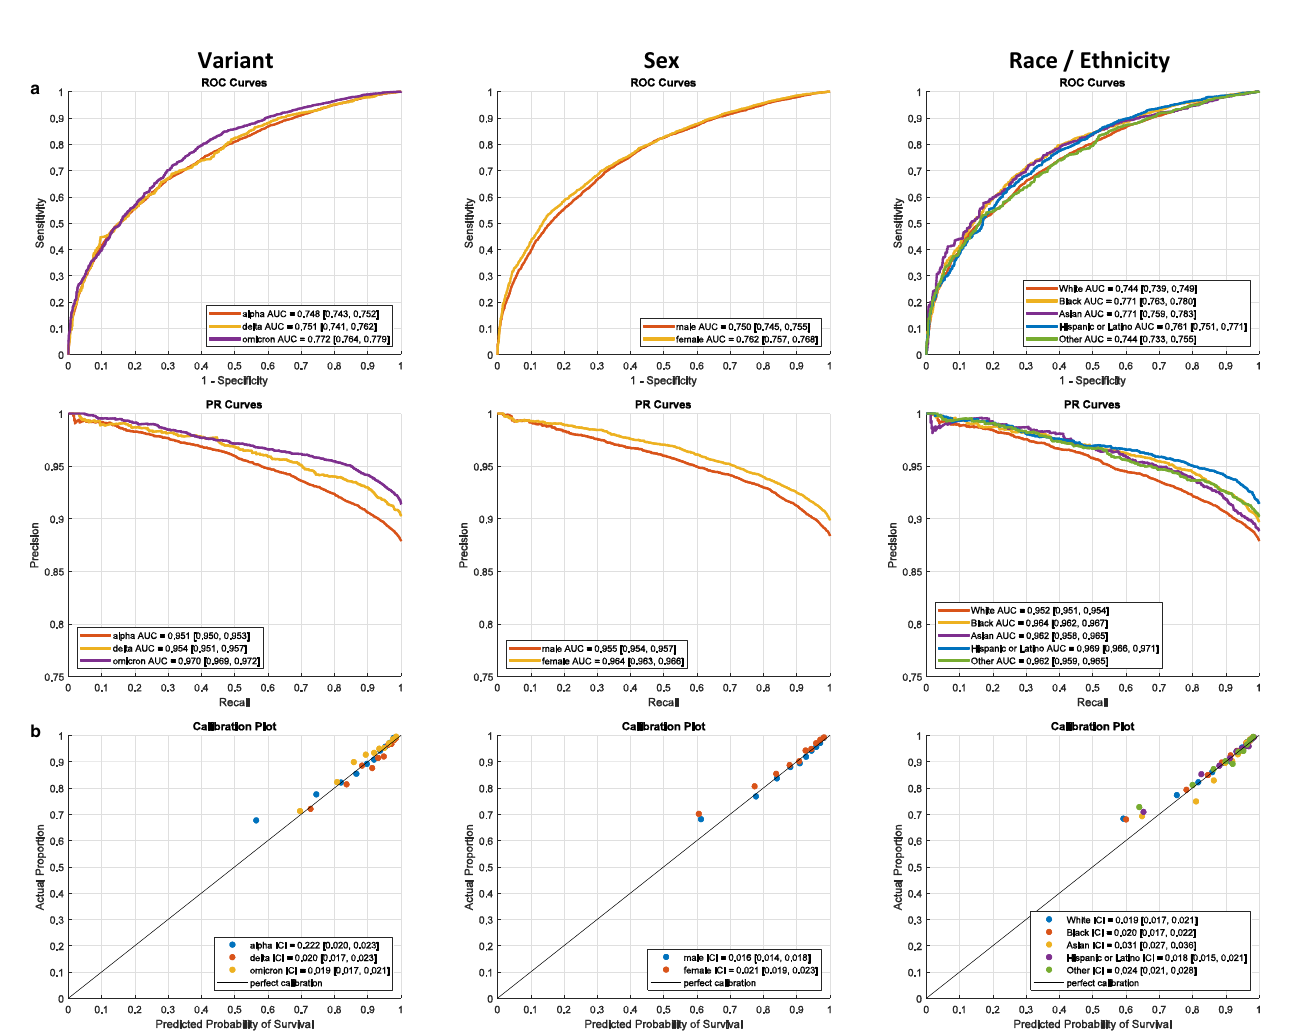
Fig. 6 | Sensitivity analysis of the 28-day updating NOCOS model across var- iants, sex and race/ethnicity. a ROC and PR curves with AUC and 95% CI for the prospective ( n = 25677) validation cohort and b their corresponding calibration plots based on the 28-day NOCOS updated with logistic recalibration. The model was fi ltered by variant, sex, and race/ethnicity. The points on the calibration plot